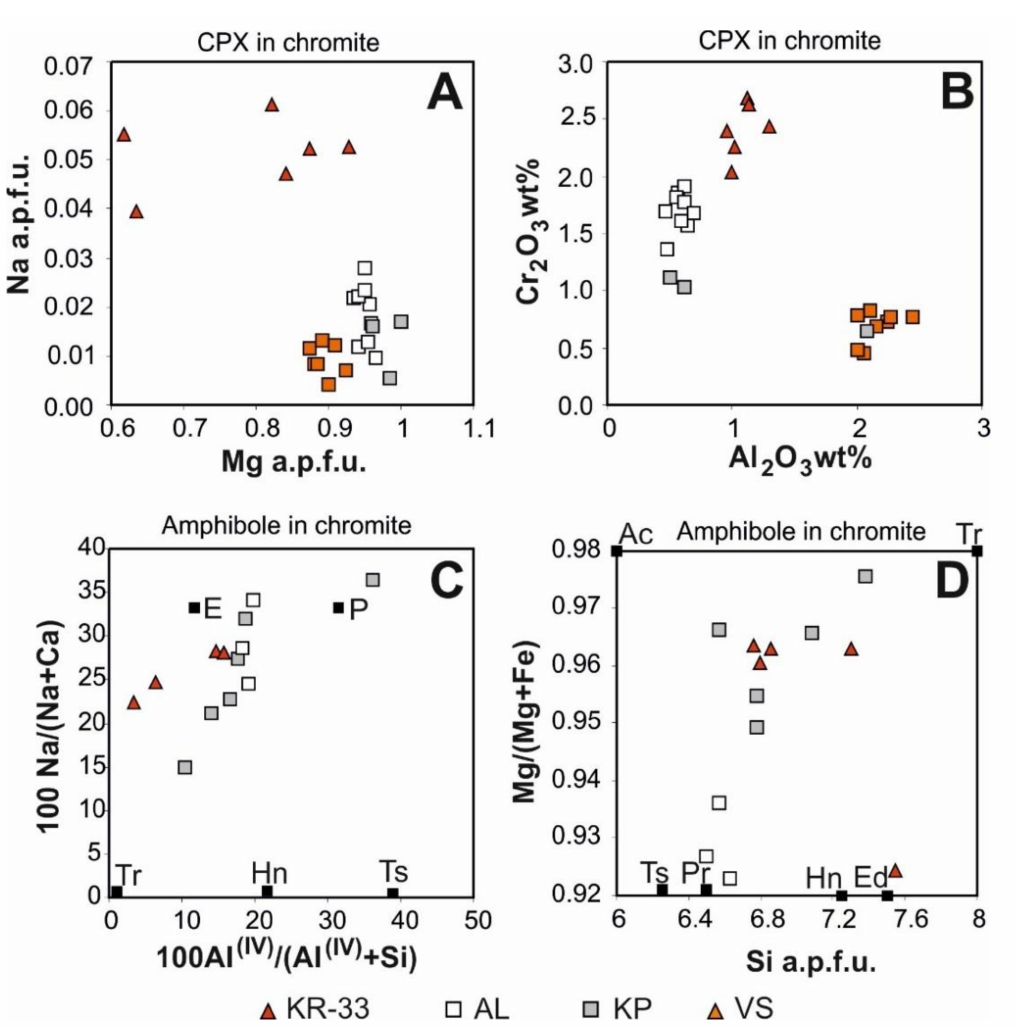
Figure 8. The clinopyroxene included in chromitite Prospect 33 (KR-33) is Na-rich and Cr-rich diopside ( A , B ). Amphibole occurring in composite inclusions is edenite-pargasitic hornblende, tending toward tremolite ( C , D ). Clinopyroxene and amphibole from Kraka are enriched in Na and Cr compared with chromitites Alapaevsk (AL), Kempirsai (KP), and Voykar Syninsky (VS). Abbreviations: Cpx = clinopyroxene; E = edenite; P = pargasite; Tr = tremolite; Hn = hornblende; Ts = tschermakite; Ac = actinolite, a.p.f.u. = atoms per formula